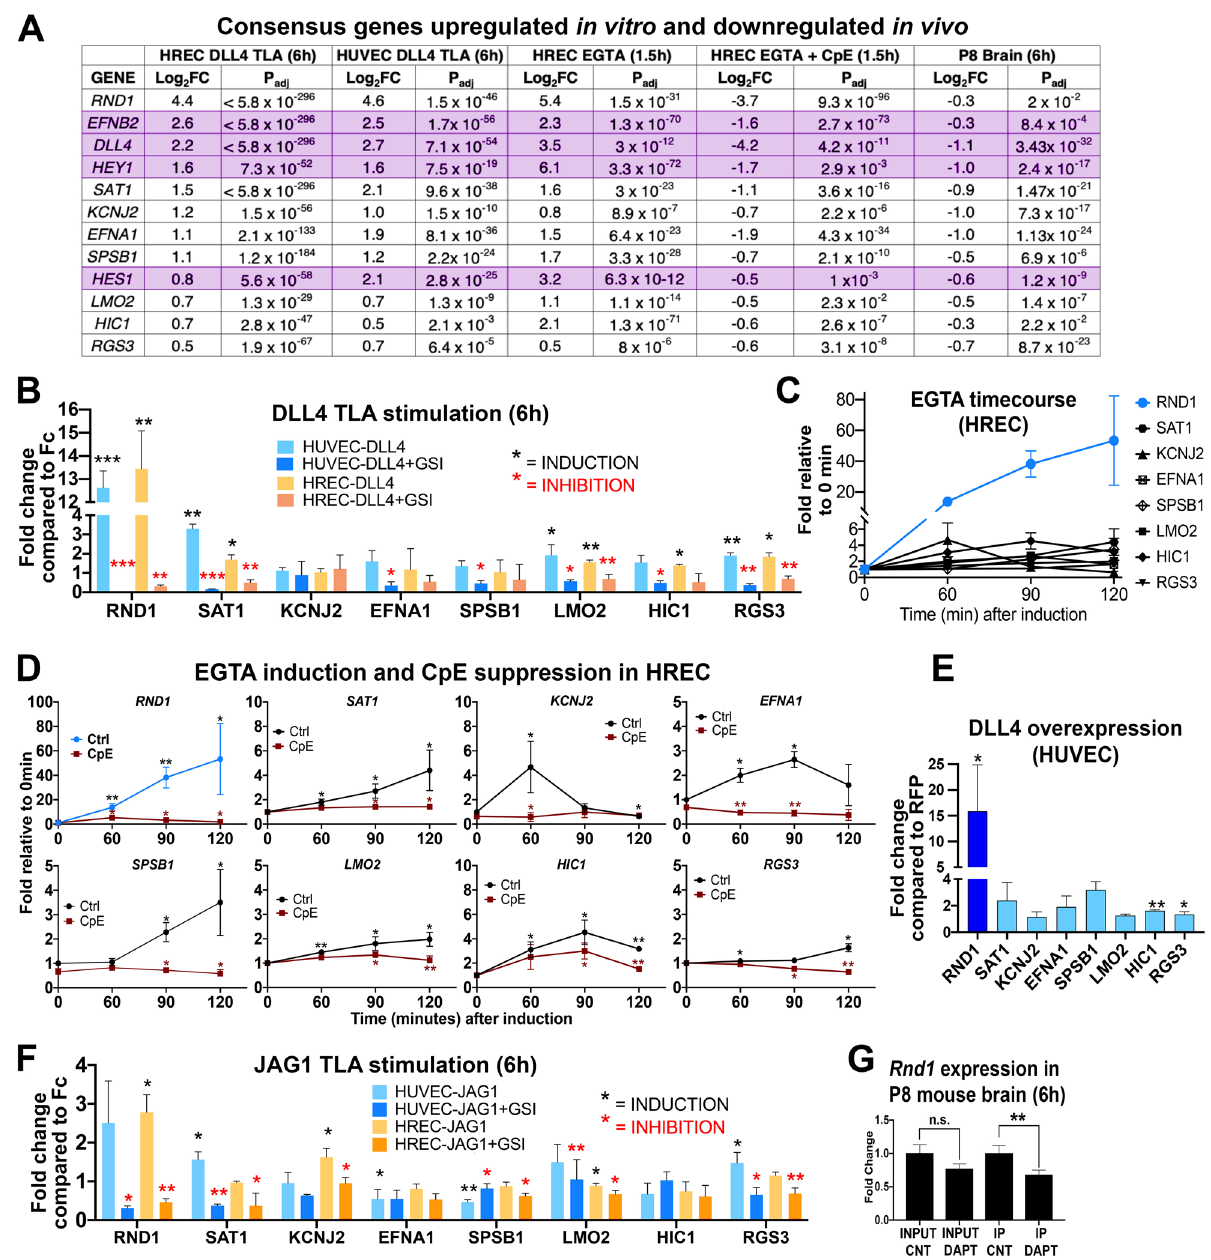
Figure 2. RND1 is the most highly regulated of the novel Notch targets in multiple contexts. ( A ) 12 genes were significantly regulated under all in vitro and in vivo RNA-seq screening conditions. Genes in purple are established Notch targets. ( B ) qPCR confirms that 7 of the 8 novel genes are regulated by DLL4 TLA in HUVEC and HREC, with RND1 showing the highest fold induction and the strongest inhibition by CpE. Black stars indicate significant induction by DLL4, red stars indicate significant inhibition of induction by CpE. ( C ) All novel targets are induced by EGTA; the most strongly induced gene is RND1 (blue line) . ( D ) EGTA induction (blue or black lines) and CpE inhibition of EGTA (red lines) of the 8 novel putative endothelial Notch targets in HREC. Black stars indicate significant induction, red stars indicate significant inhibition of induction. The y axes are scaled for each gene to visualize induction of different magnitudes. ( E ) RND1, HIC1 , and RGS3 remain induced after 48 h of DLL4 overexpression, while the other novel targets have transient expression that has returned to baseline after 48 h. ( F ) JAG1 TLA induces expression of most novel endothelial Notch targets at lower levels, suggesting that RND1 is a target of both DLL4 and JAG1 signaling. ( G ) qPCR of endothelial transcripts immunoprecipitated from the P8 mouse brain using an endothelial-specific RiboTag allele. Input = bulk brain homogenate, IP = immunoprecipitated endothelial